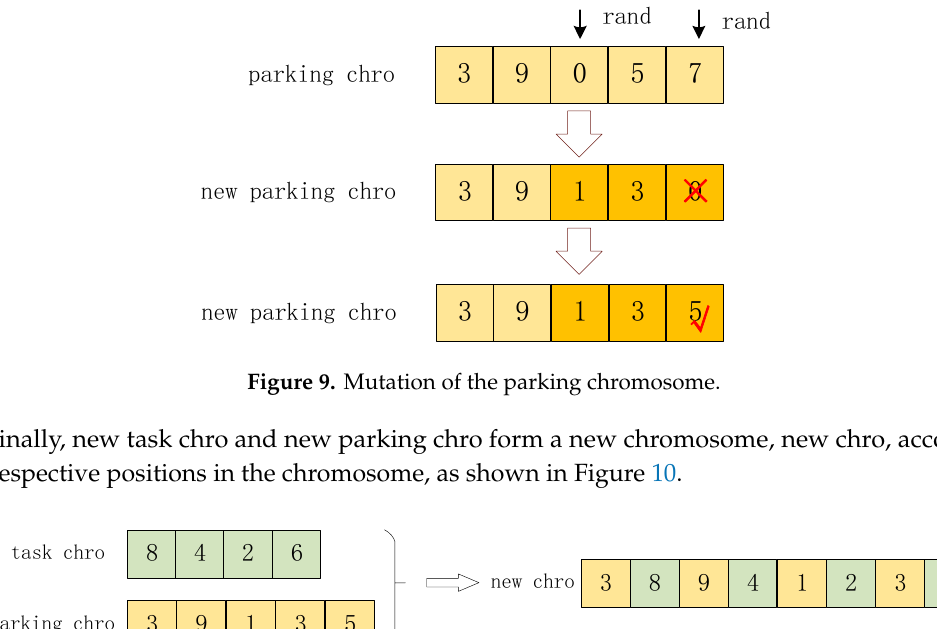
Figure 8. Task chromosome mutation: ( a ) inversion mutation and ( b ) exchange mutation.